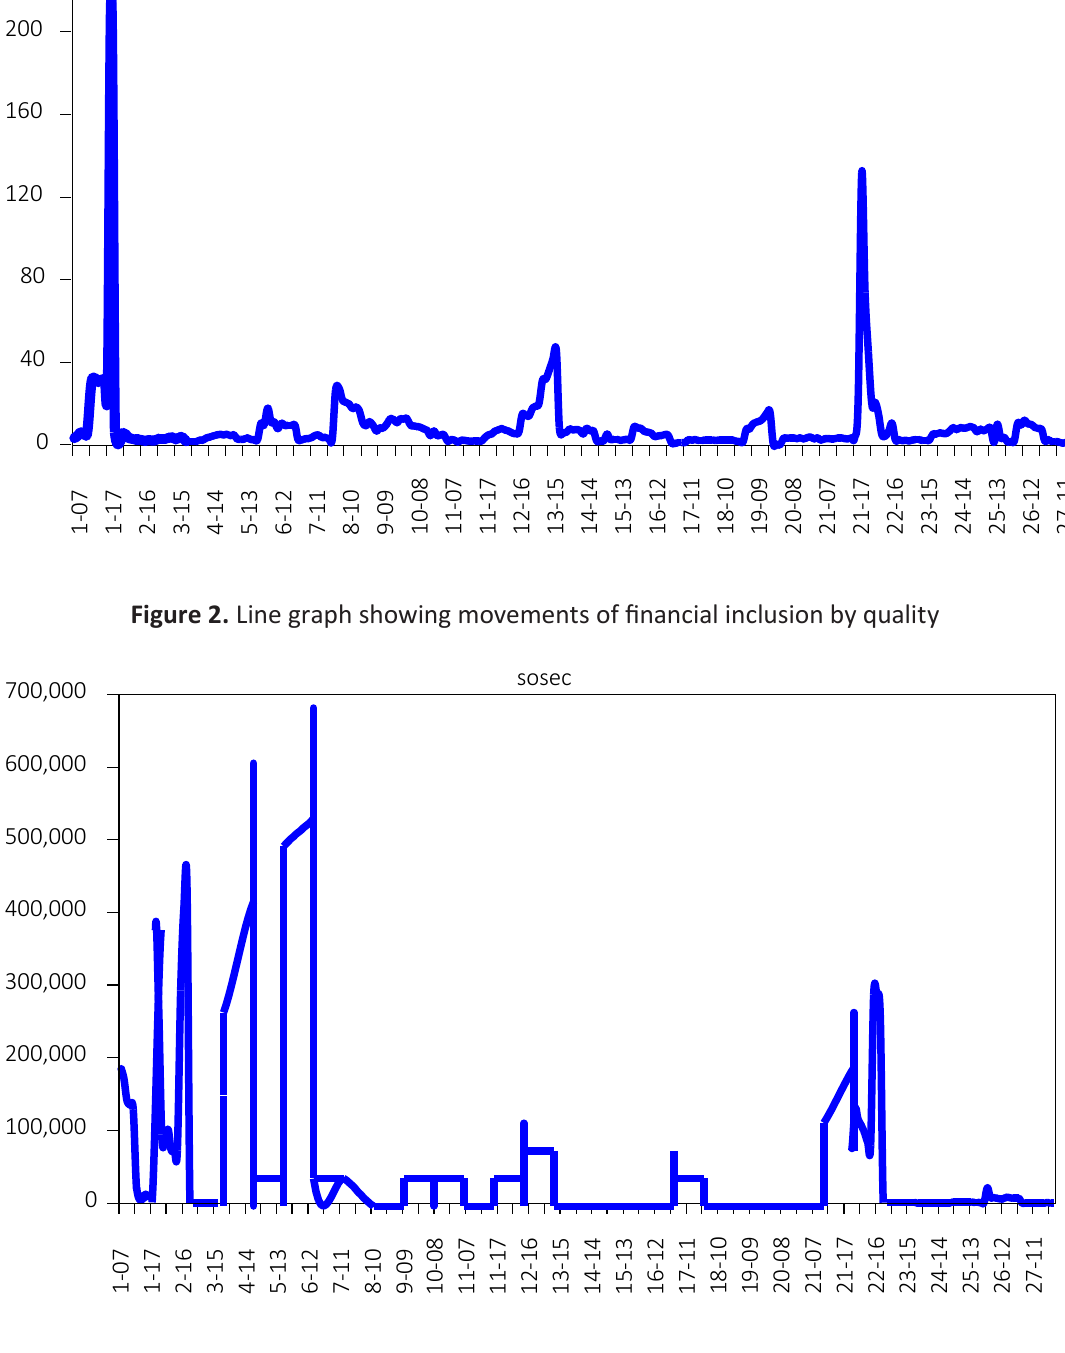
Figure 3. Line graph showing movements of social